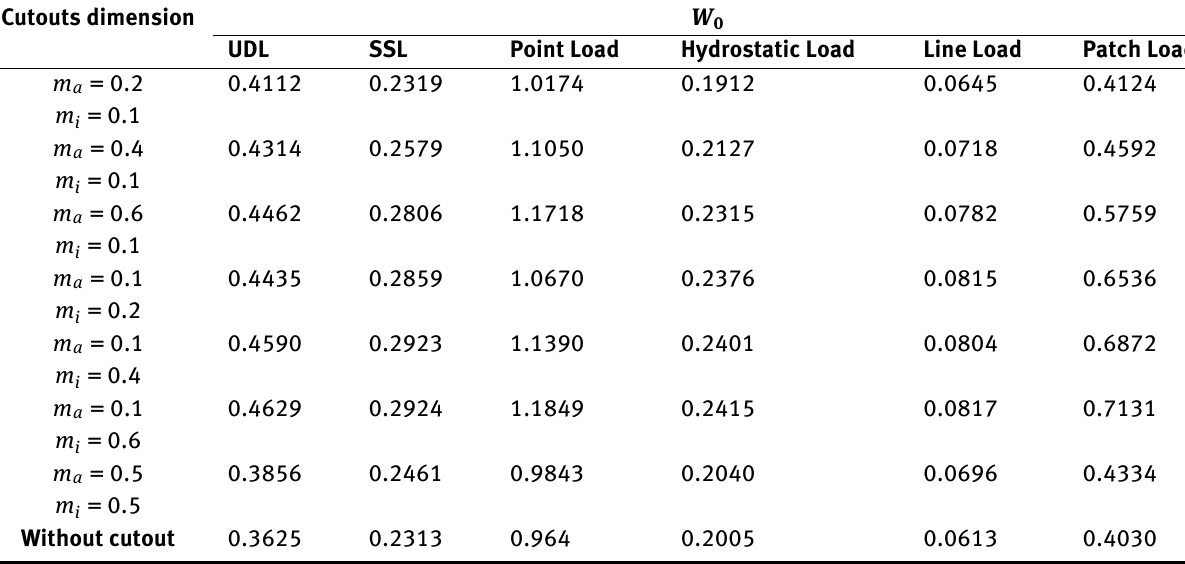
Table 9: Variation of NTMD with loading conditions for laminated composite sandwich square plate with clamped edges Cutouts